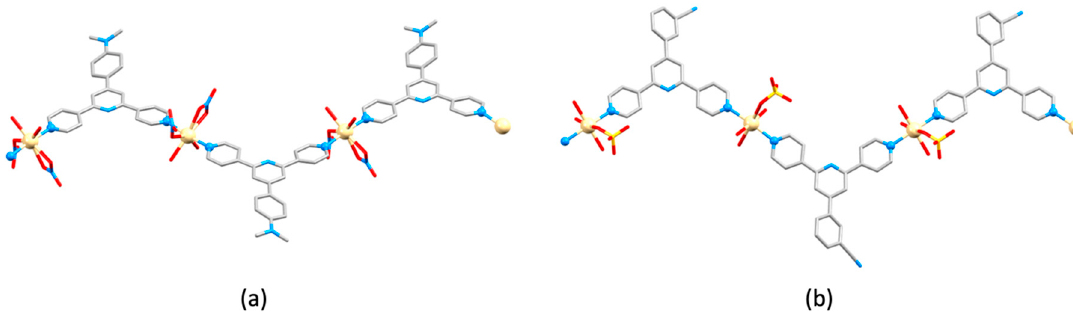
Figure 31. Part of the 1D ‐ ladder (a) in [Cd( 29 )(OH 2 ) 2 (NO 3 ) 2 ] n . n H 2 O (CSD refcode VAKWOV) and in (b) [Cd 2 ( 51 ) 2 (SO 4 ) 2 (H 2 O) 6 ] n . n H 2 O (refcode NUNZON).